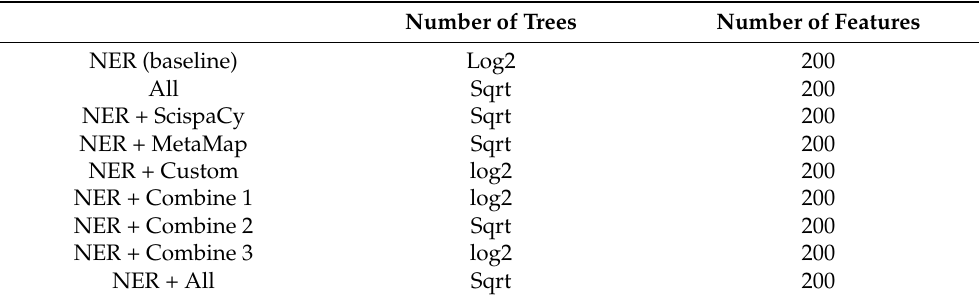
Table 6. Optimal hyperparameter combinations for random forest models trained on information features. Number of Trees Number of Features